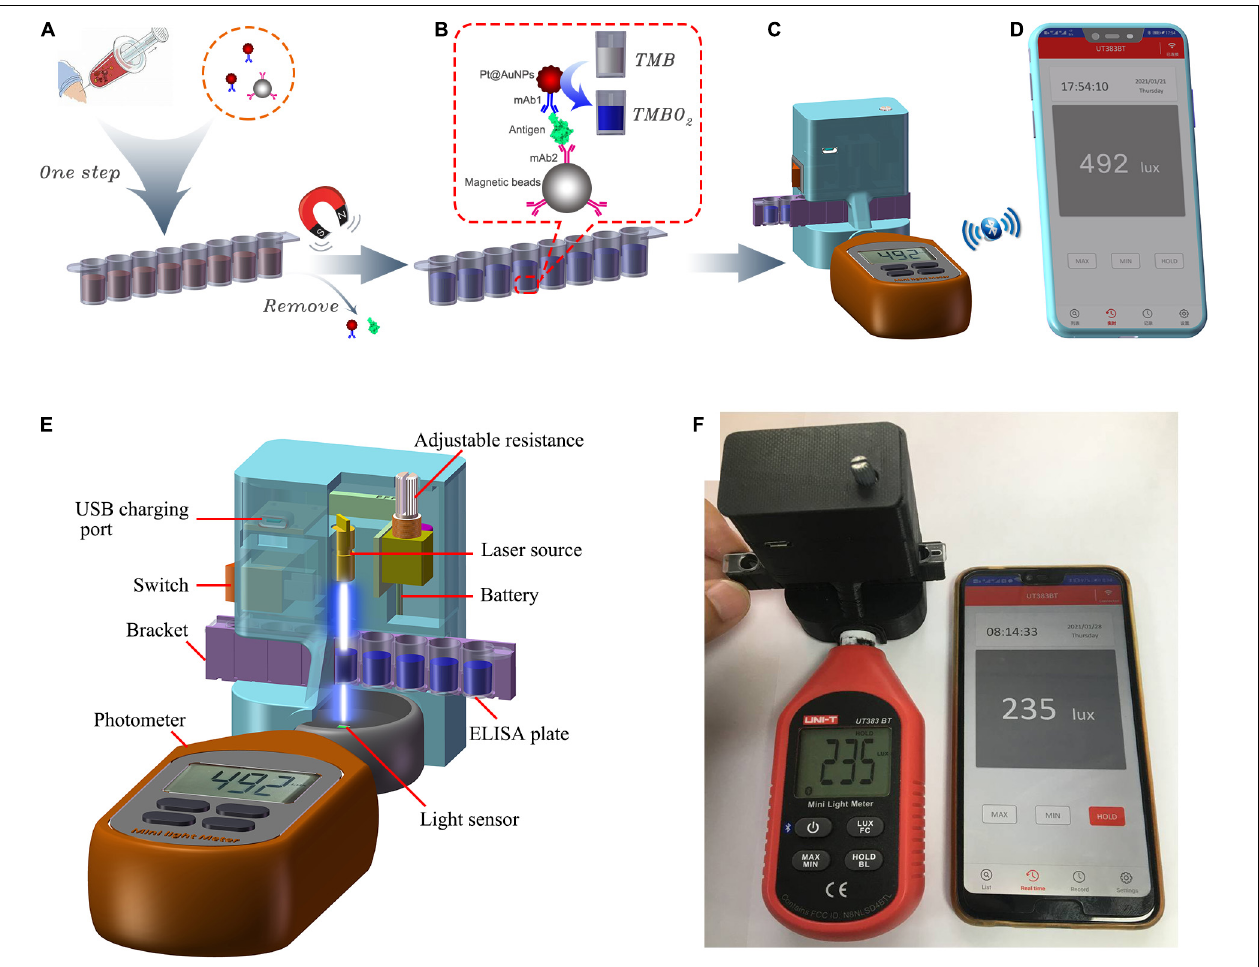
FIGURE 1 | The schematic diagram of SP-NLISA. (A) The serum sample (1:1 diluted with sample buffer) was aliquoted into the freeze-dried microwells and mixed for 40 min at 37 ◦ C. (B) The magnets were used to capture the complexes after washing and the substrate solution (50% TMB + 50% H 2 O 2 ) was catalyzed by Pt@AuNPs in the complexes for 10 min at 37 ◦ C. (C) The microwells were located in the smartphone-based device and (D) the results were shown using the iENV app. (E) The main structure of the smartphone-based device for NLISA and (F) its connection with the app (iENV) in the smartphone via